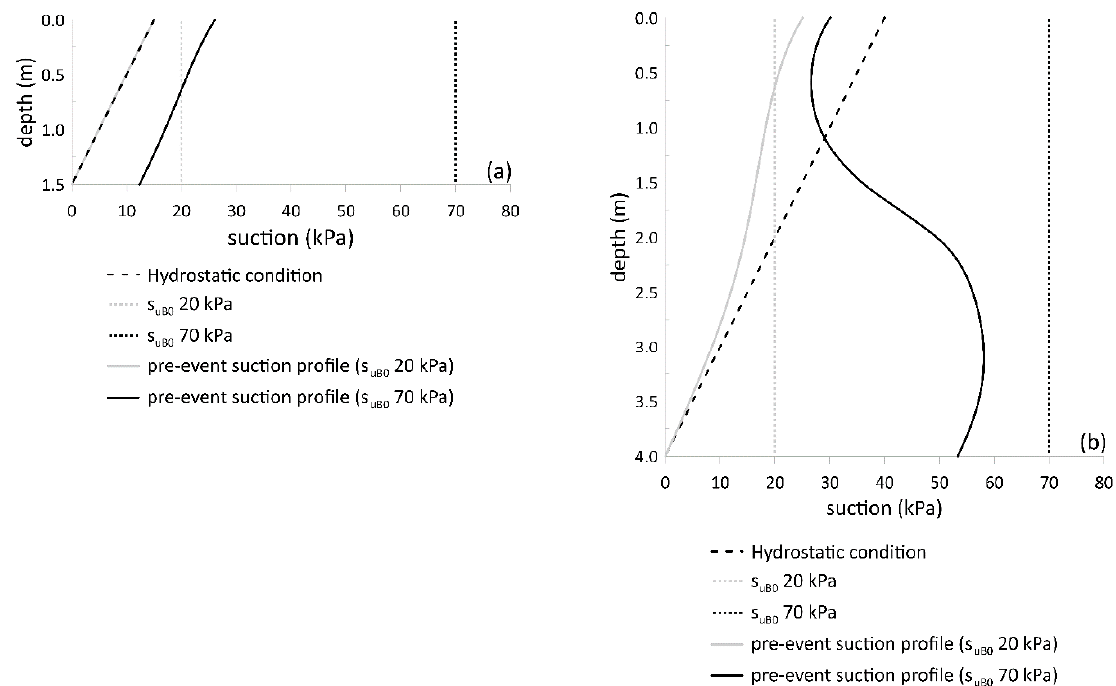
Figure 12. Results of set D analyses: suction distributions computed for two different initial suction values, at the end of the antecedent period defined by backdating the critical event on 1st January 2005: